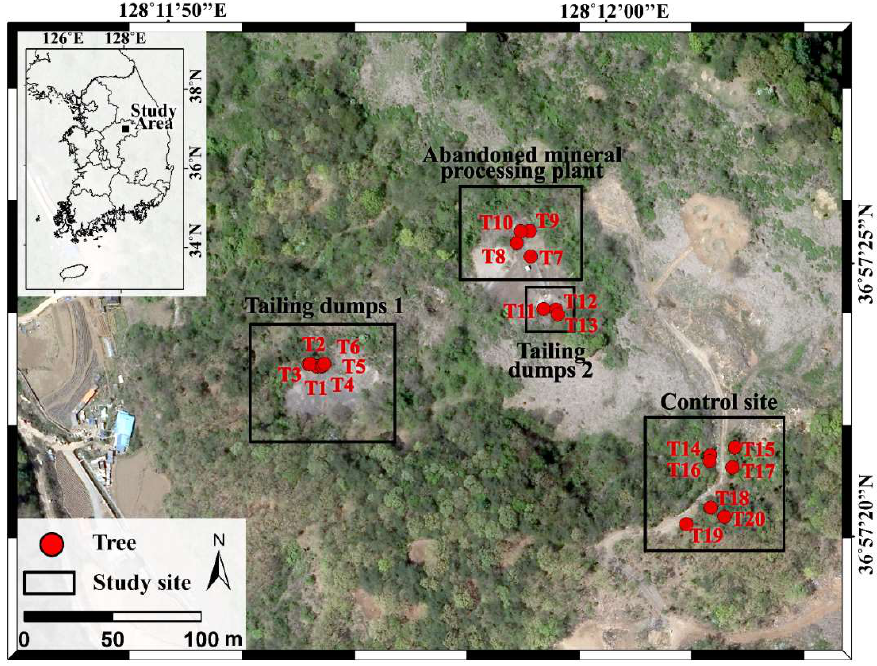
Figure 1. An aerial photograph of the study area (Boksu Pb–Zn mine) showing sampling locations.